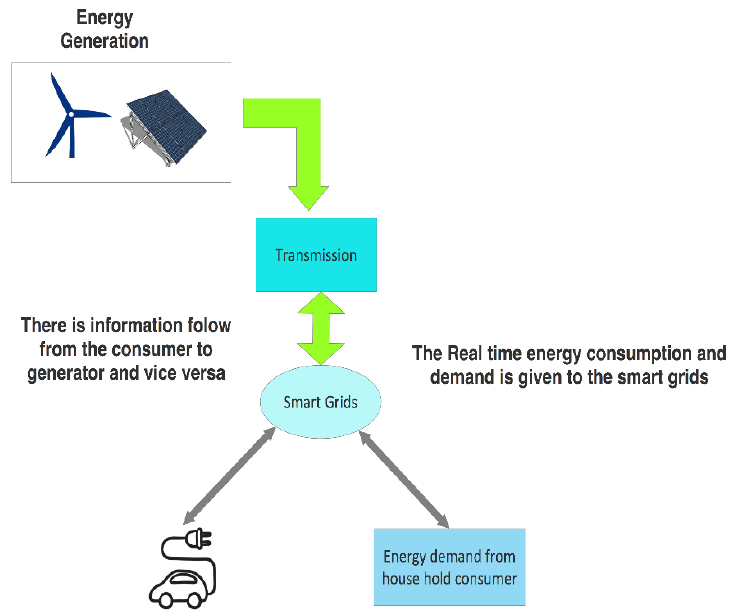
Figure 9. Overview of a smart grid for electric vehicle demand management.